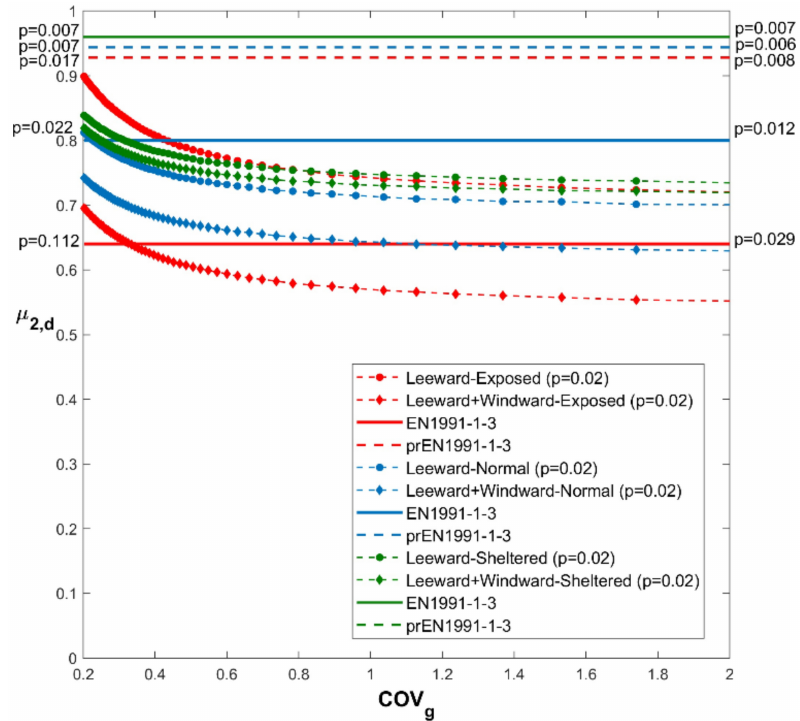
Figure 9. Design shape coefficient for pitched roofs ( µ 2, d ) with 25 ◦ < α < 30 ◦ as a function of the coefficient of variation ( COV g ) of the ground snow load, parameterized in terms of exposure conditions (sheltered: green lines, normal: blue lines, exposed: red lines).